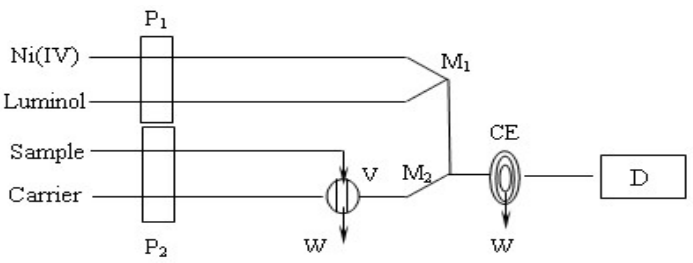
Figure 3. Schematic of the flow injection analysis CL system for SAL/TEB determination, where P is the peristaltic pumps, V is the six-way injection valve, M is the manifold, CE is reaction cell, W is waste, and D is a photomultiplier tube detector.